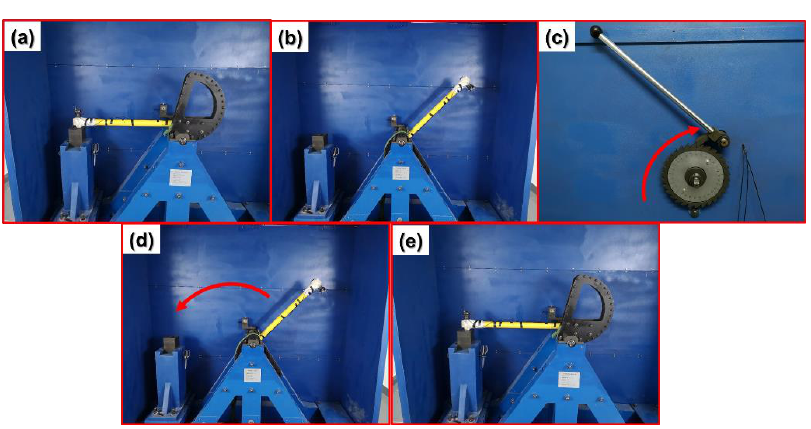
Figure 16. The machete hammer ( a ) used to generate high-g impact and its working process: ( b ) Lifting the hammerhead. ( c ) Pulling on the trigger. ( d ) Dropping the hammerhead. ( e ) Hitting the base to generate a high- g